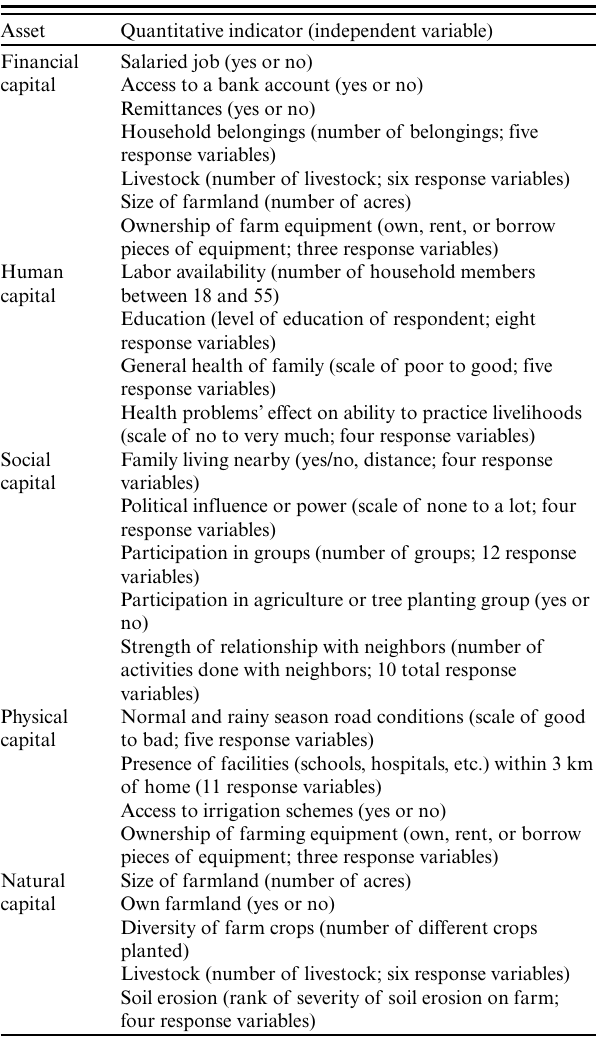
Table 1. List of household survey livelihood resilience